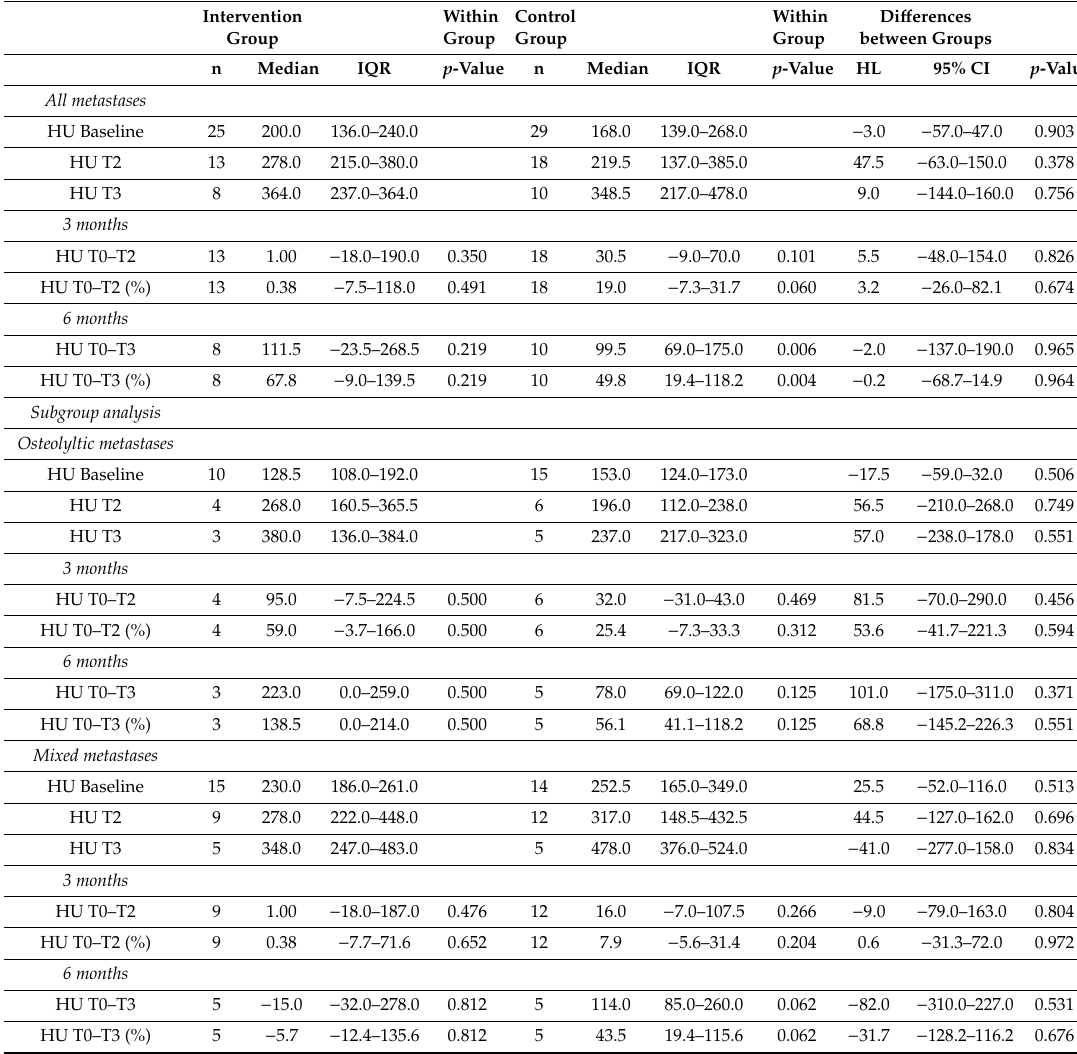
Table 3. These results demonstrate the bone density (HU = Hounsfield units) in metastatic bone before RT (baseline), three and six months after RT. The results were presented by absolute and relative values (%) of HU within and between group as median (Hodges–Lehmann estimate) and